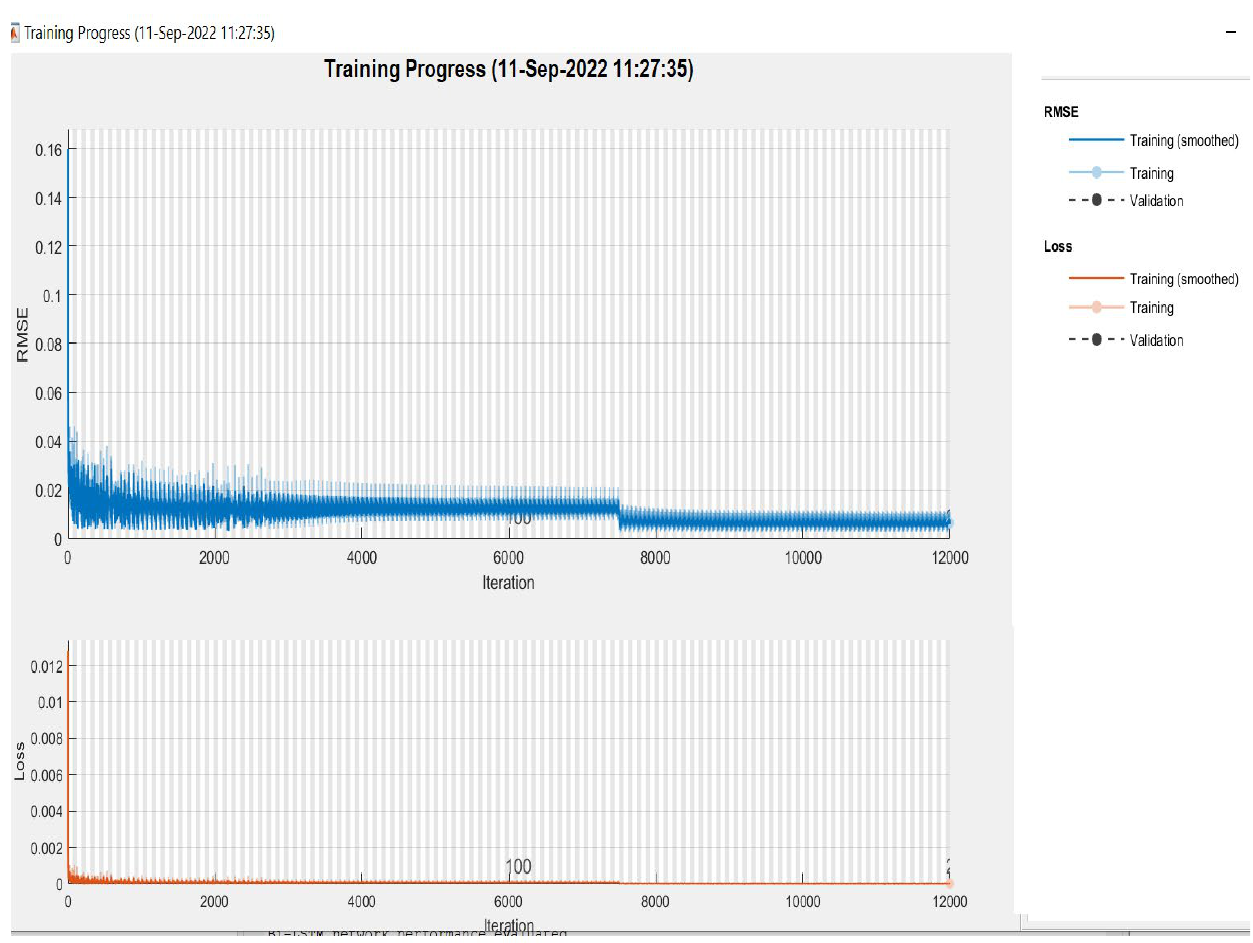
Figure 5. Snapshot of the performance model. Table 2. Performance of the LSTM model in the training stage.